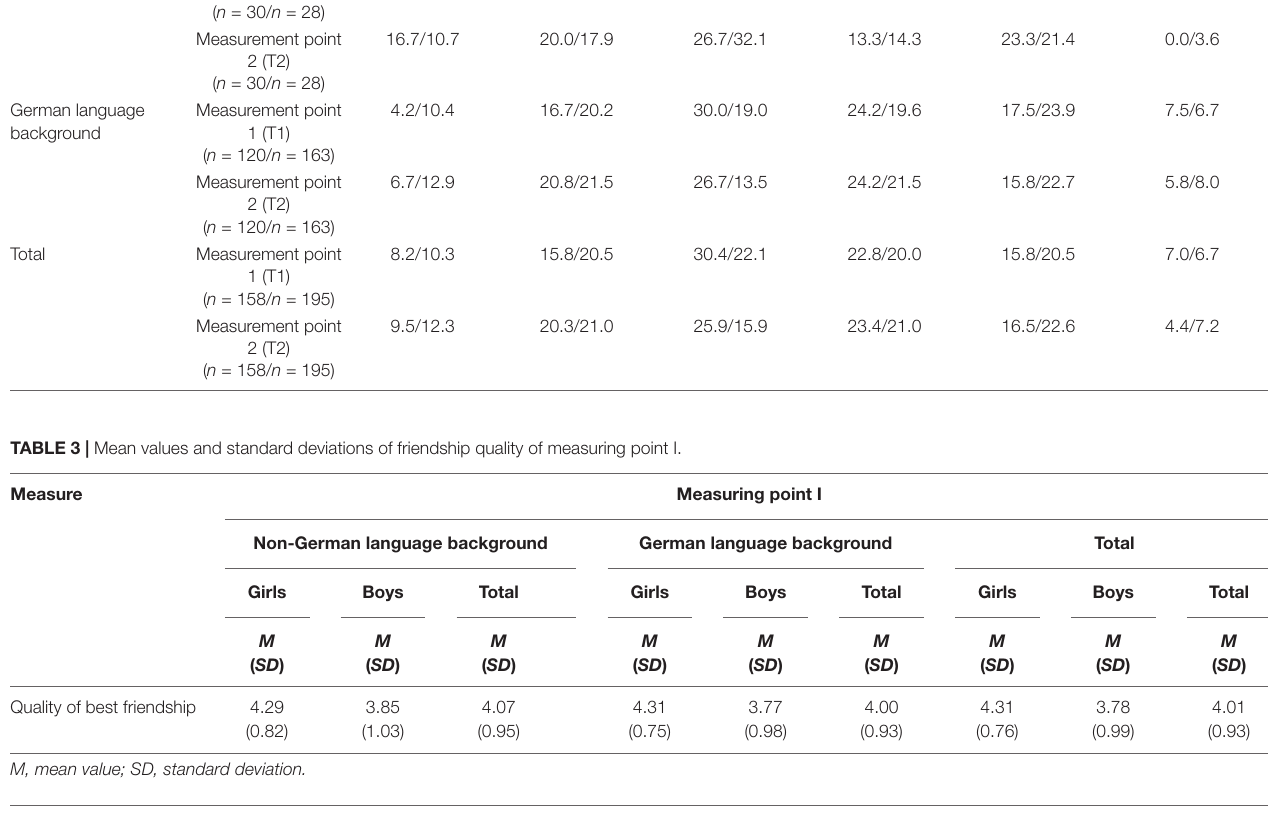
TABLE 4 | Mean values and standard deviations of friendship quality of measuring point II.